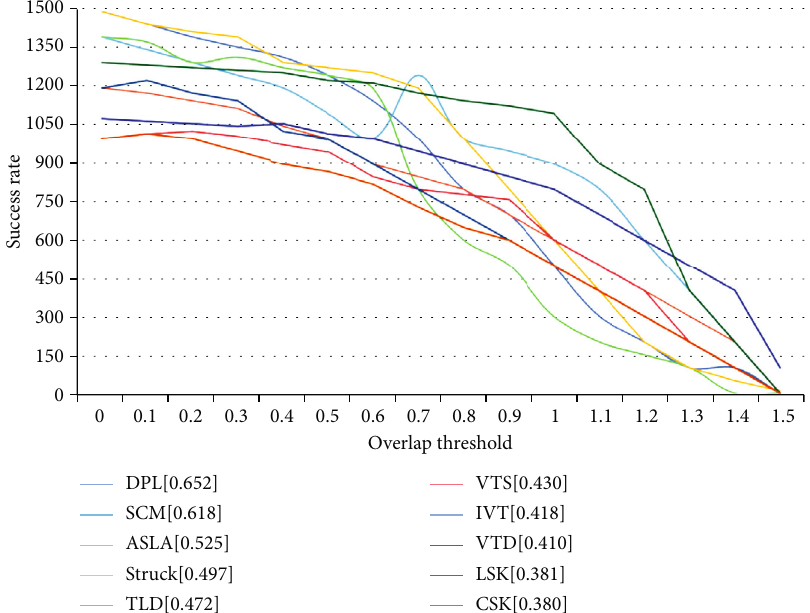
Figure 5: Success rate and accuracy plots across all video sequence frames.